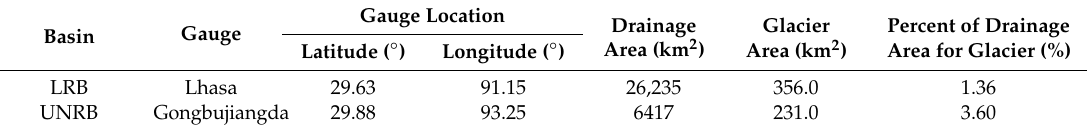
Table 1. Characteristics of the study basins.